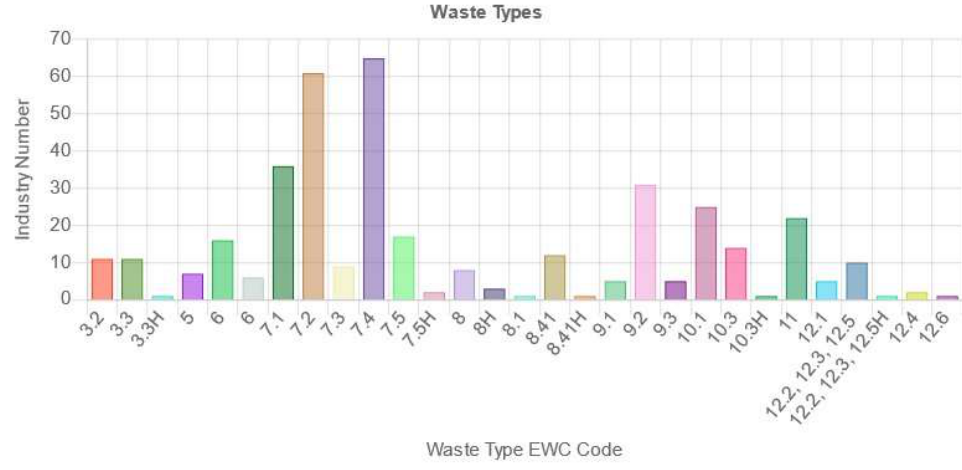
Figure 4. Available waste profile of the SWAN industrial ecosystem in Cyprus.